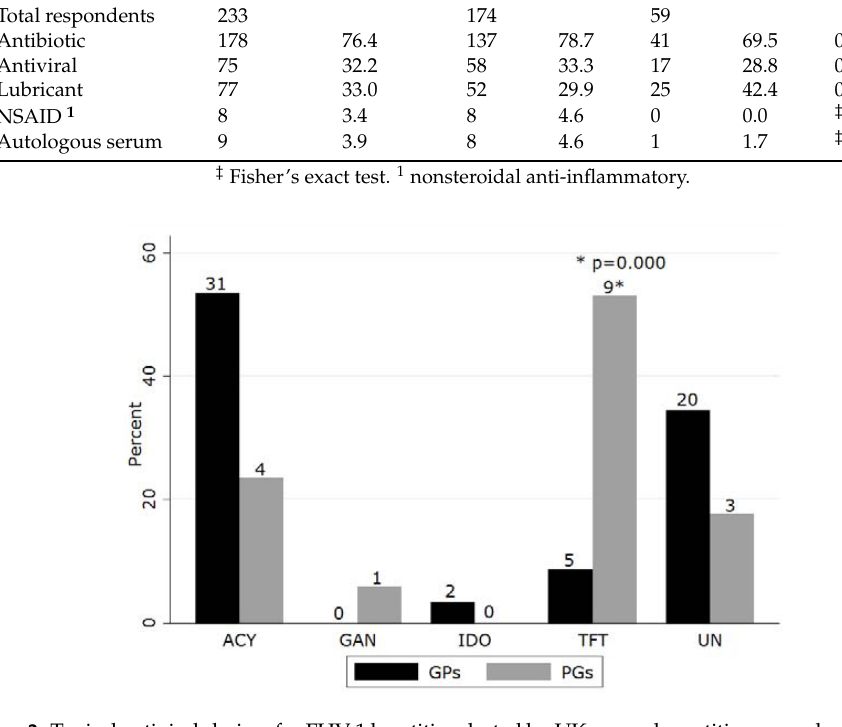
Figure 3. Topical antiviral choices for FHV ‐ 1 keratitis selected by UK general practitioners and postgraduate groups who suggested topical antiviral therapy in a questionnaire ‐ based survey (ACY, acyclovir; GAN, ganciclovir; IDO, idoxuridine; TFT, trifluorothymidine; UN, unspecified; numbers indicate number of respondents suggesting treatment).